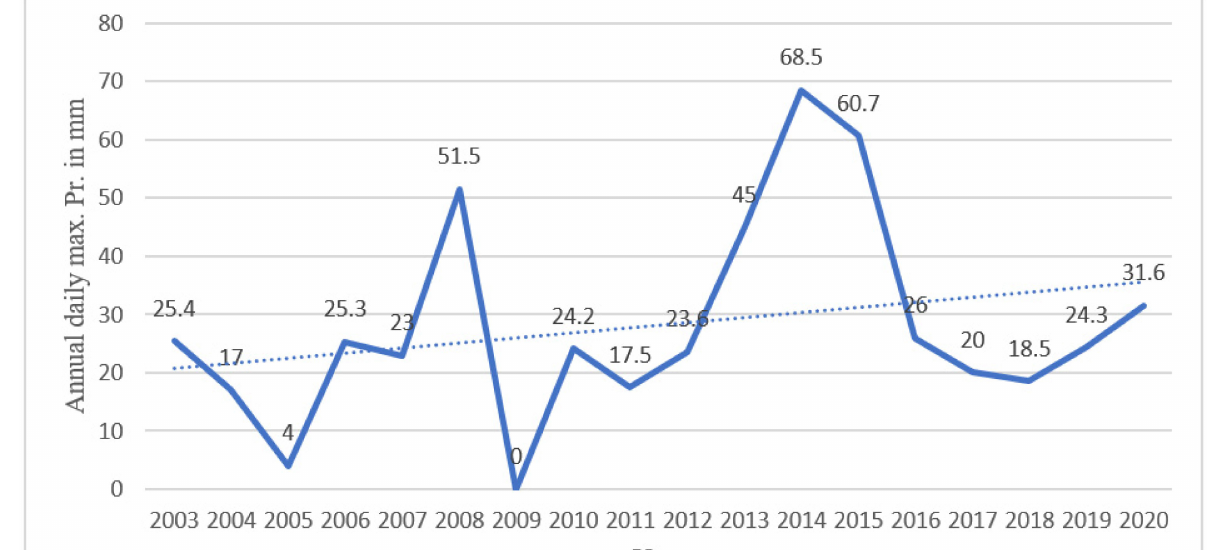
Figure A9. Observed annual daily maximum precipitation of Manang Bhot, Manang.